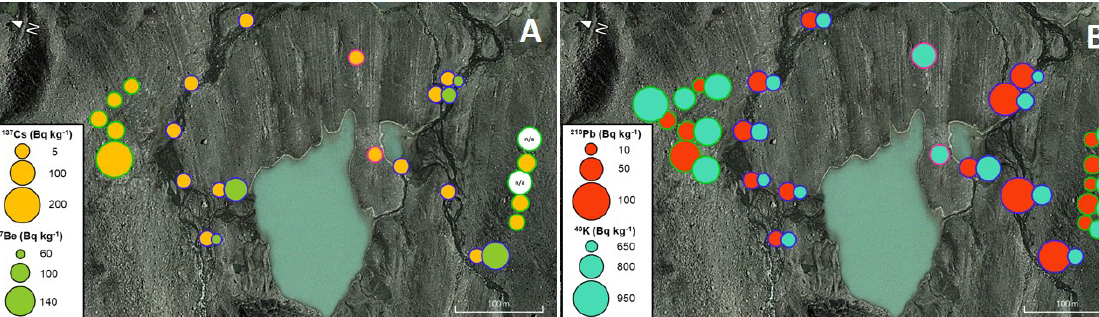
Figure 7. Spatial variability of selected radionuclide activities detected in proglacial sediment samples from the central forefield, moraines, and proglacial outwash (sampled within the mobile braided stream network). The sampling points are centred beneath the yellow and orange circles in panels (A) and (B) respectively. Circles with a green outline denote samples from moraines, circles with a blue outline denote samples from proglacial outwash, and circles with pink outlines denote samples from the central forefield. Note that neither 137 Cs nor 7 Be were detected above the minimum detectable amount for two moraine samples (A) and that 7 Be was only detected in proglacial outwash samples, the lake core, and cryoconite (the latter two are not shown here). Imagery source: Google Earth, 67 ◦ 54 (cid:48) 55.25 (cid:48)(cid:48) N, 18 ◦ 35 (cid:48) 32.13 (cid:48)(cid:48) E (image from 8 October 2013) © Google Earth.